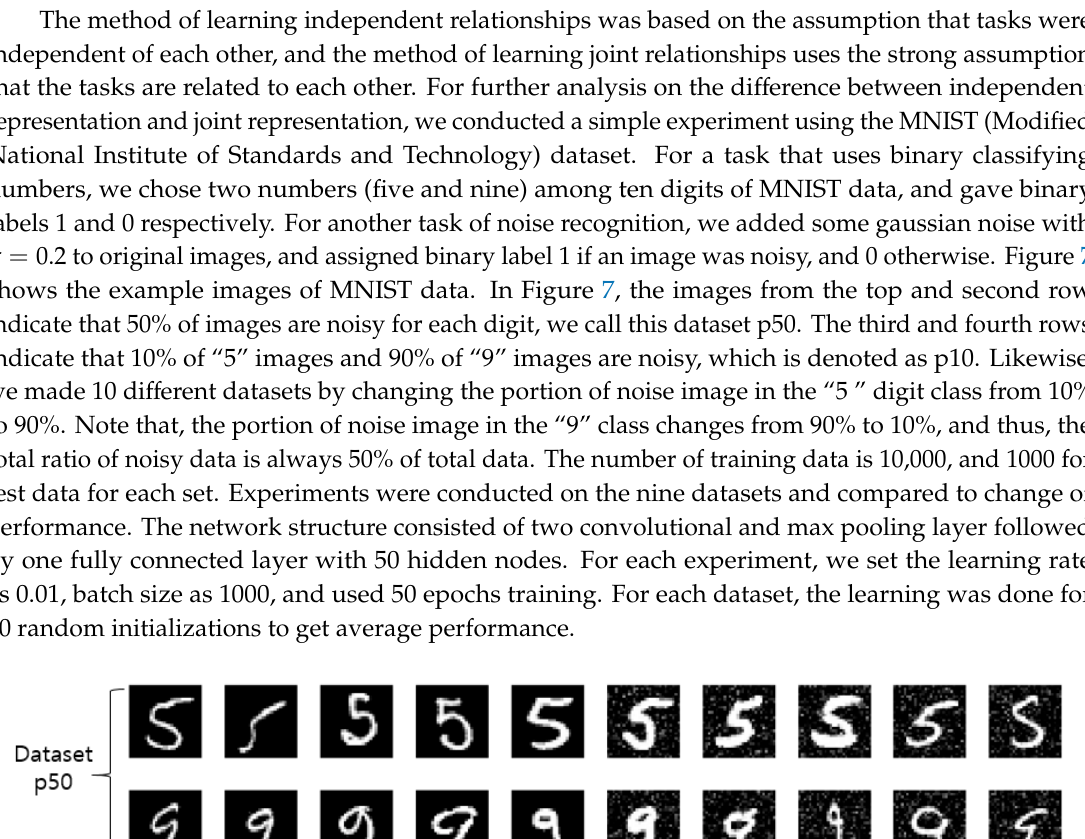
Figure 8. Classification rate (%) for digit recognition.